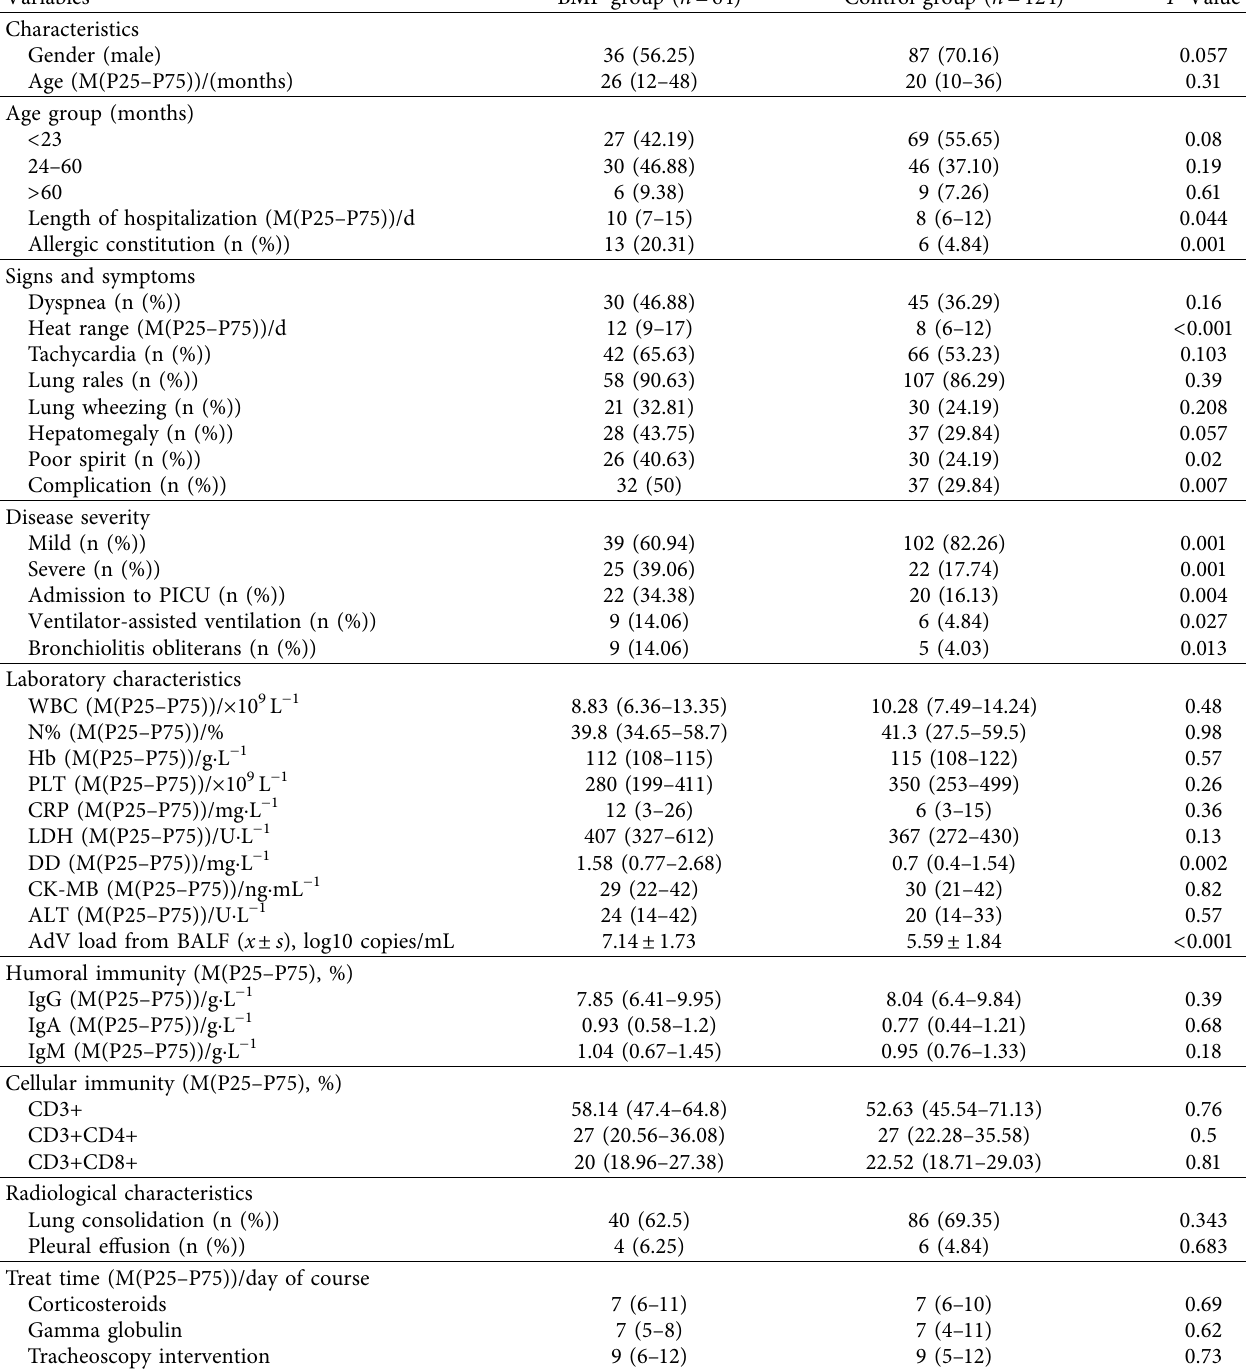
Table 2: Comparison of the clinical characteristics of patients with single AdV infection in the BMP and control group.